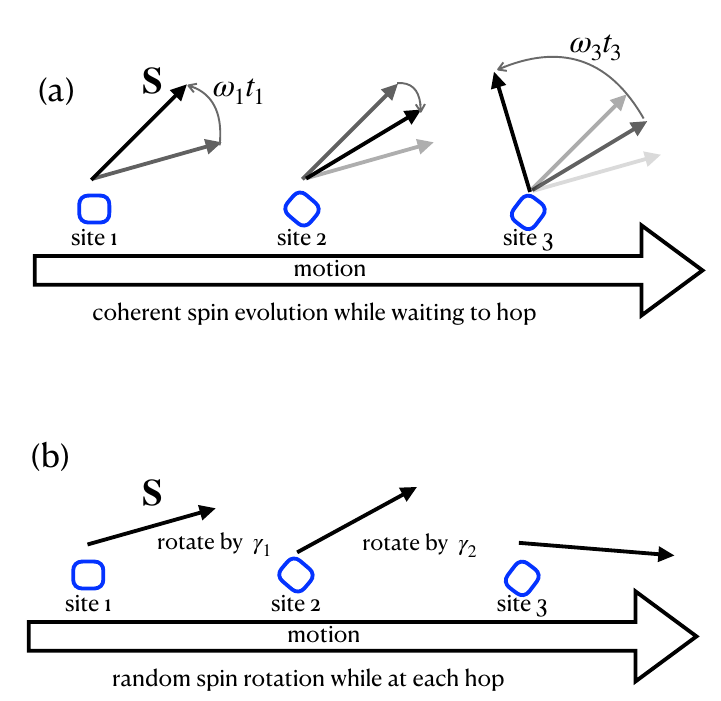
Figure 1. (Color online) ( a ) Intrasite spin evolution where the precession angle ( ω t ) depends on the wait time at the site ( t i at the i th site) and the random local field. Arrow shading represents the chronology of spin evolution: the oldest times are represented by lighter grays with shade darkening to the current time, t , which is black. ( b ) Intersite spin evolution, which is independent of the wait time. At each hop, the spin undergoes a spin rotation, γ , due to a random local